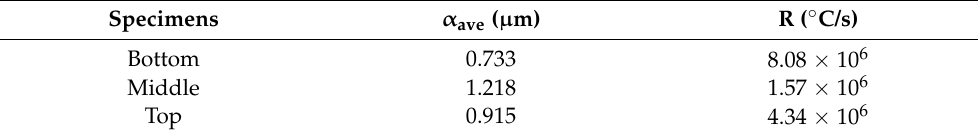
Figure 5. Comparison of the EBSD images for the three specimens with different heights: ( a – c ) the pole figure and inverse pole figure of bottom, middle and top, respectively; ( d ) statistics on the fraction of high-angle grain boundaries (HAGBs) and large-size grains (over 100 μ m). Additional Supplementary data are shown in Figures S1–S3. Table 3. Cooling rate predicted from experimental